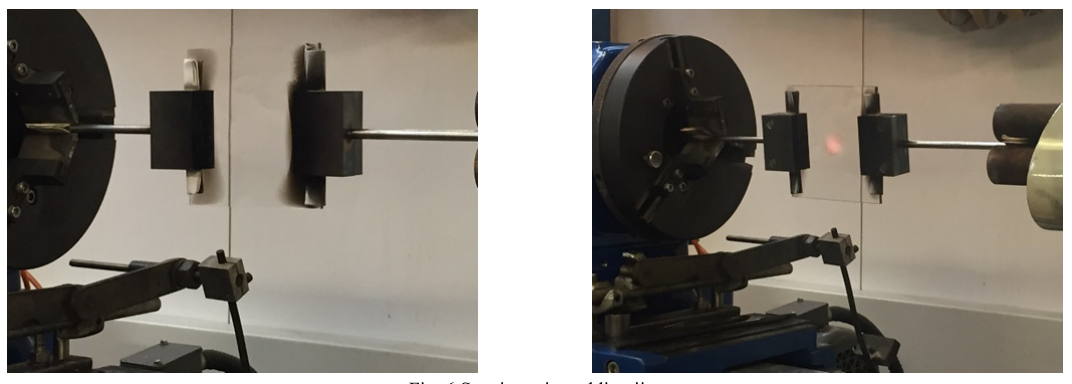
Fig. 6 Specimen in welding